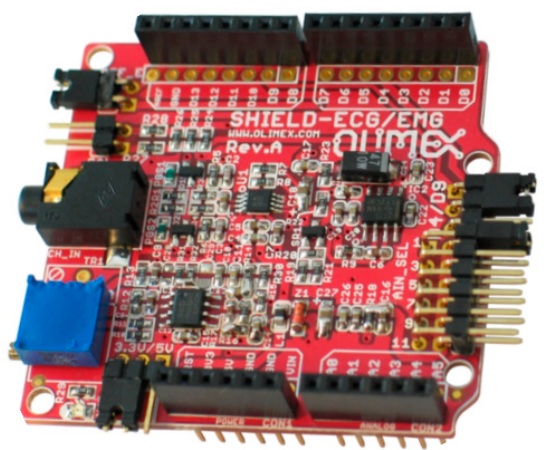
Figure 1. The Olimex ECG/EMG Arduino shield (image from Olimex ECG/EMG shield manual).